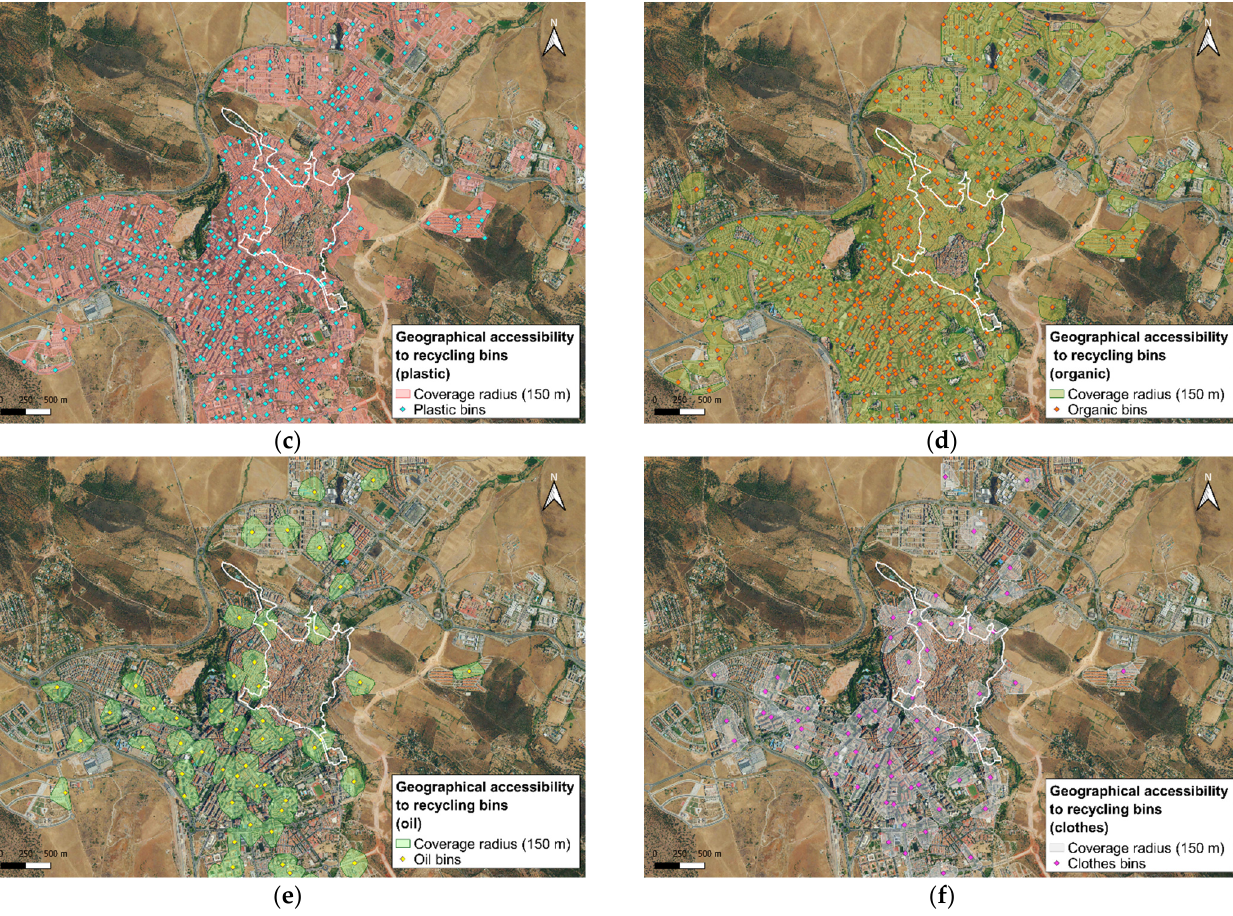
Figure 7. Maps of distance to different waste separate collection rubbish bins: ( a ) glass; ( b ) paper and cardboard; ( c ) plastic; ( d ) organic; ( e ) oil; ( f ) clothes.